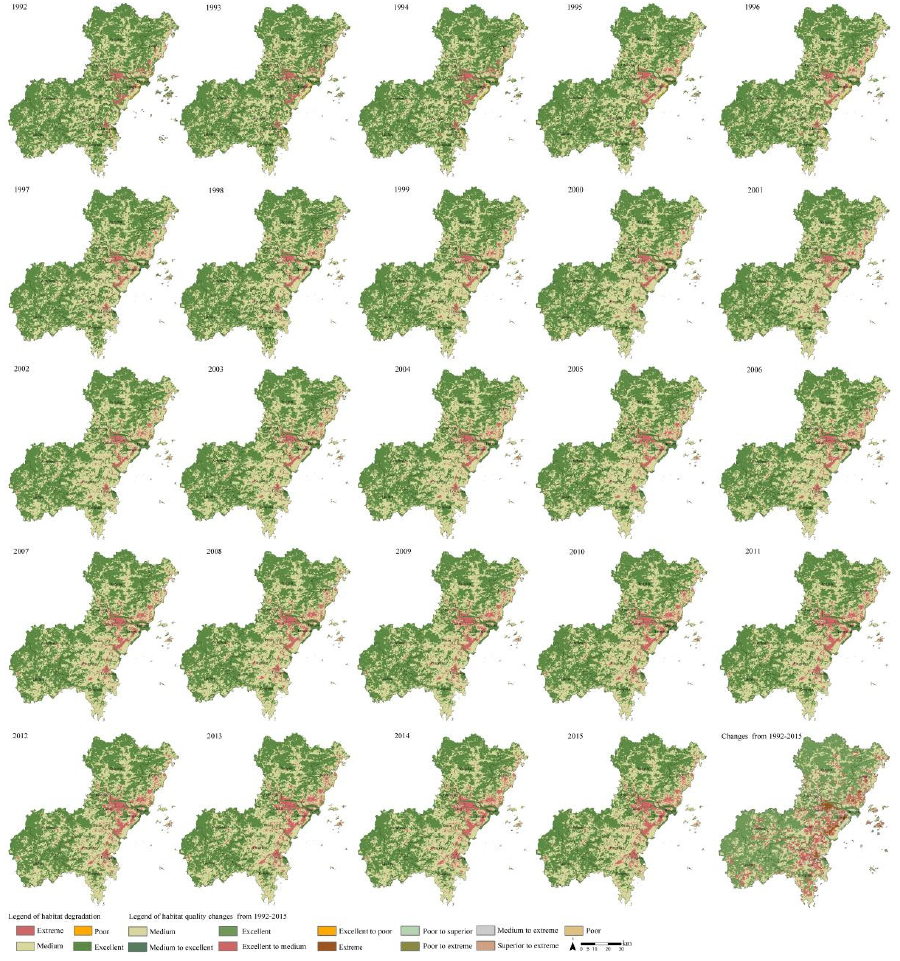
Figure 3. Changes in habitat quality in Wenzhou City from 1992 to